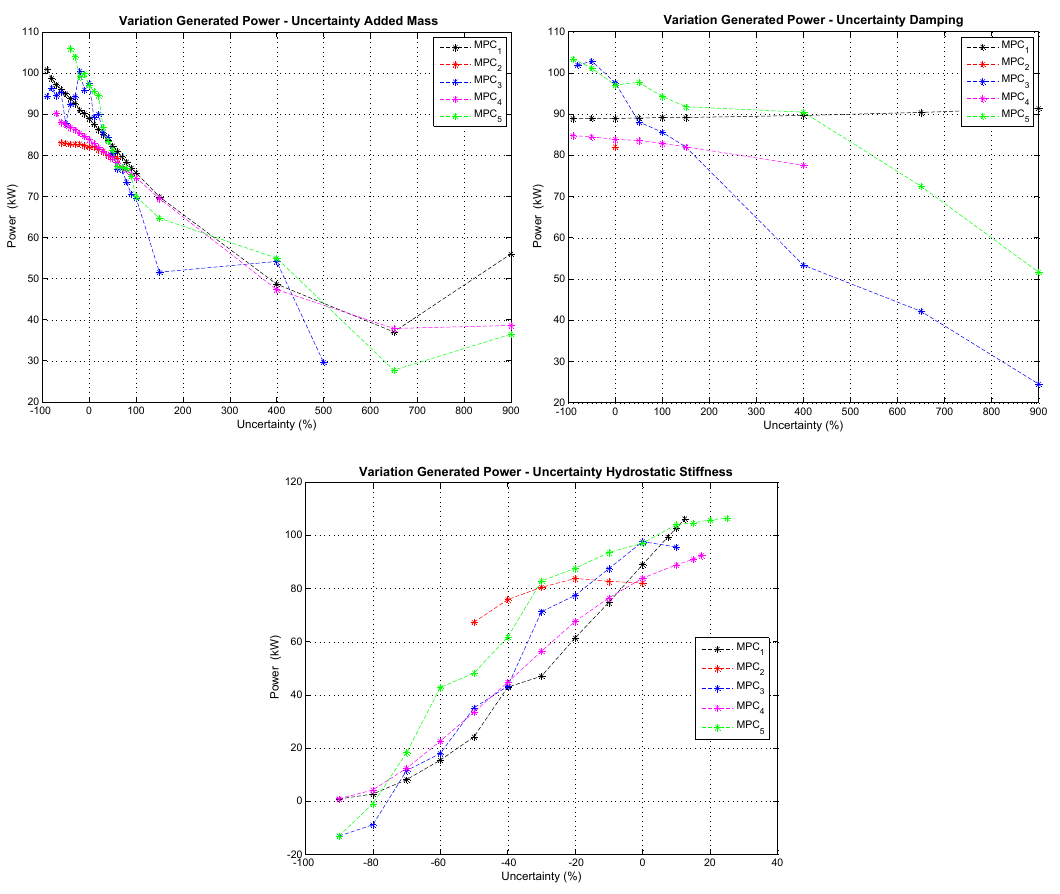
Figure 9. Variations of the average mechanical power generated as a function of the added uncertainty to: added mass, damping coefficient and hydrostatic restoring